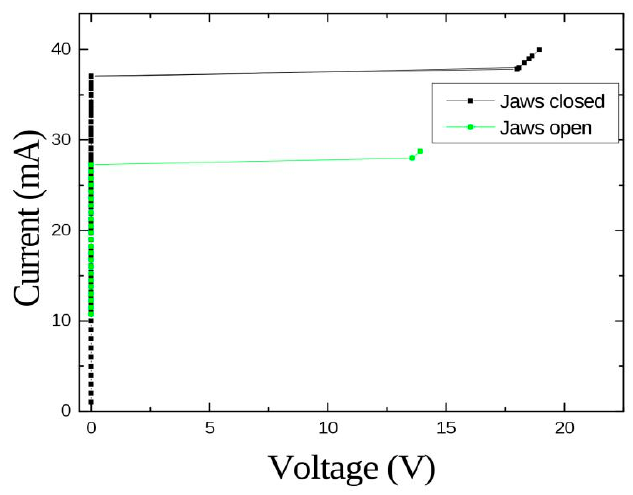
Figure 5. Current-voltage curves under irradiation/no irradiation; the drop in the critical current is clearly visible. The transition takes place at a voltage identified by a change of slope in the curves. (Adapted from [12], with the permission of IOP Publishing).